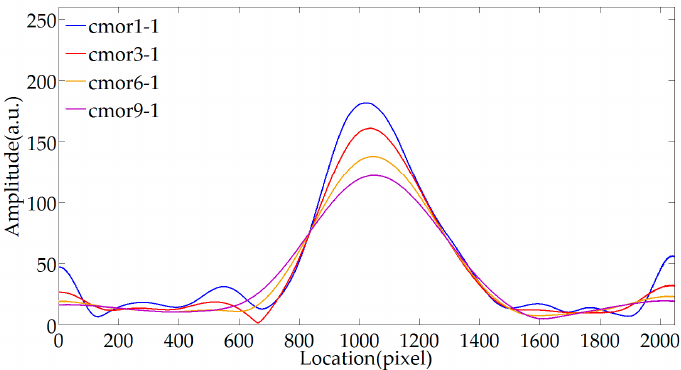
Figure 9. Impact of bandwidth parameter on envelope extraction.